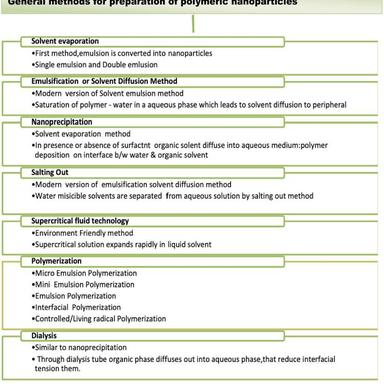
General methods for the preparation of polymeric nanoparticles of PEG-PCL.